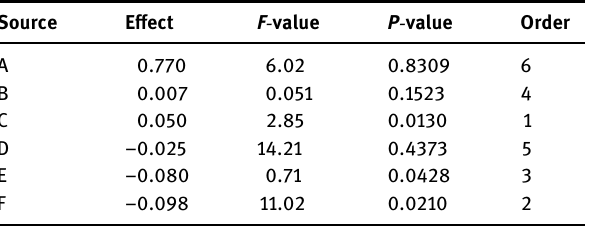
Table 4: Actual factor levels corresponding to coded factor levels in